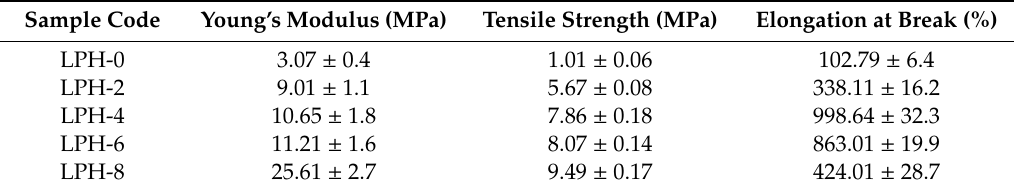
Table 3. Mechanical properties of PHA-based polyurethane films.